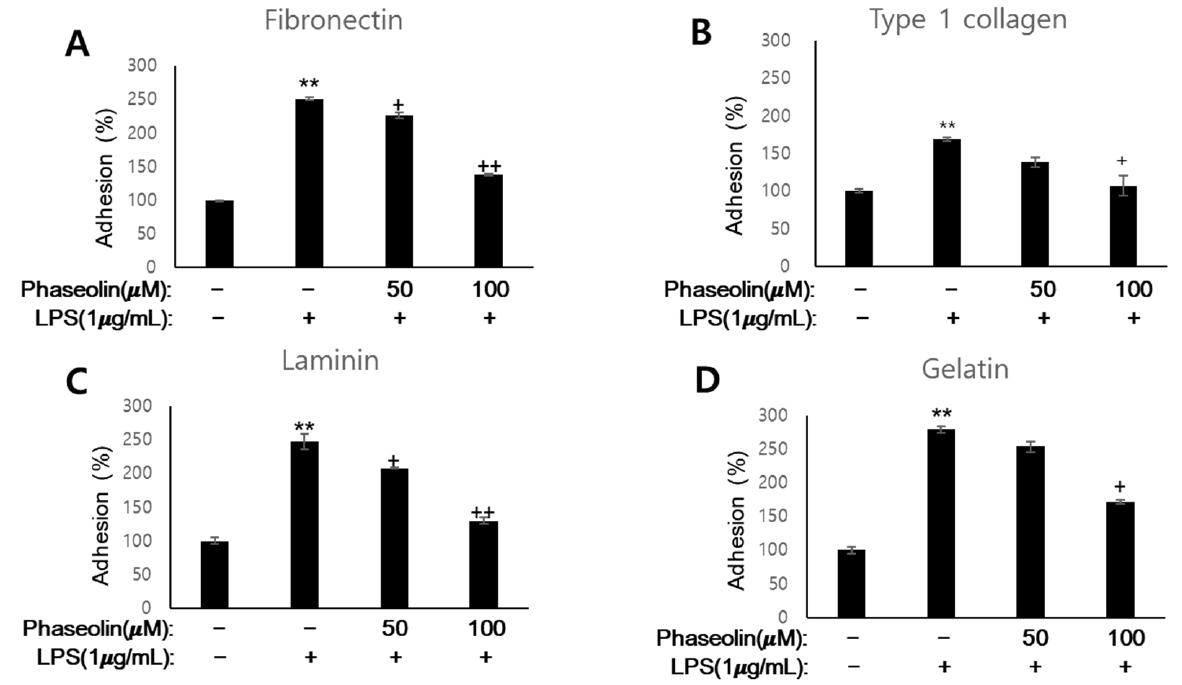
Figure 3. Effects of phaseolin on cell-to-matrix adhesion, in vitro. RAW 264.7 cells were treated with LPS (1 µ g/mL) alone or LPS + phaseolin (50 or 100 µ M) for 24 h and then incubated in extracellular matrix protein-coated 96-well plates for 15 min. Adhesion to fibronectin ( A ), type I collagen ( B ), laminin ( C ), and gelatin ( D ) was quantified, expressed as relative values, and normalized to 100%. Values shown in the graphs indicate the mean ± SD. ** p < 0.01, vehicle vs. LPS-treated group; + p < 0.05 and ++ p < 0.01, LPS vs. LPS plus phaseolin-treated group.